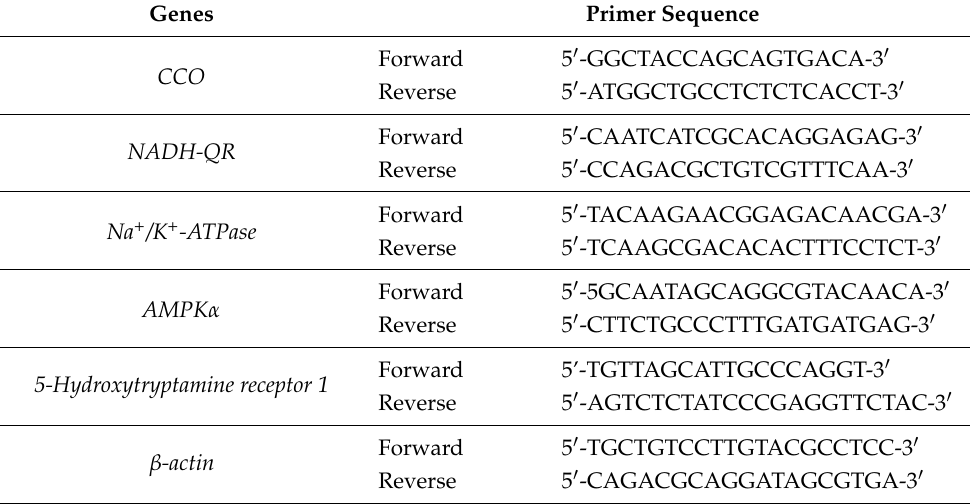
Table 1. Sequences of specific